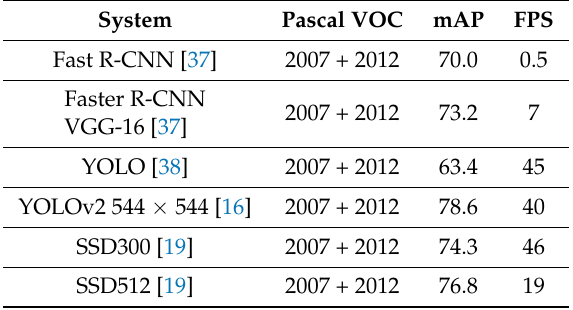
Table 6. Comparison of accuracy and speed between detectors on the Pascal VOC dataset. System